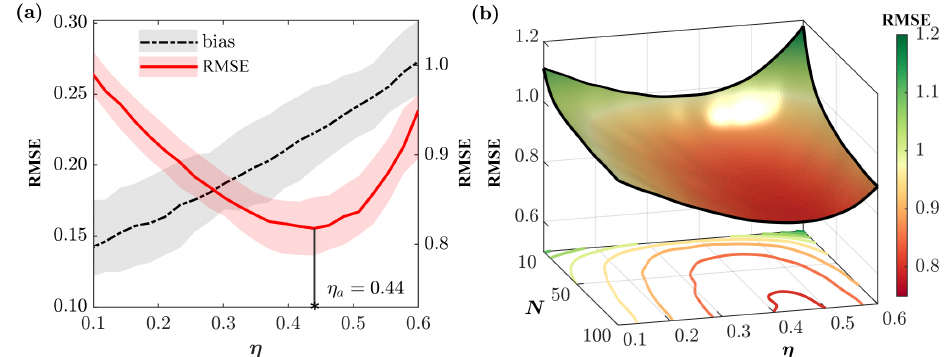
Figure 4. (a) Bias and RMSE for a range of displacement parameter η ∈ [ 0 . 1 , 0 . 6 ] in EnRDA with 50 ensemble members, obtained across 40 dimensions of the Lorenz-96 system. The shaded regions indicate the 5th–95th percentile bound for the respective error metrics obtained from 50 independent simulations. (b) Variation of RMSE as a function of the number of ensemble members and η .